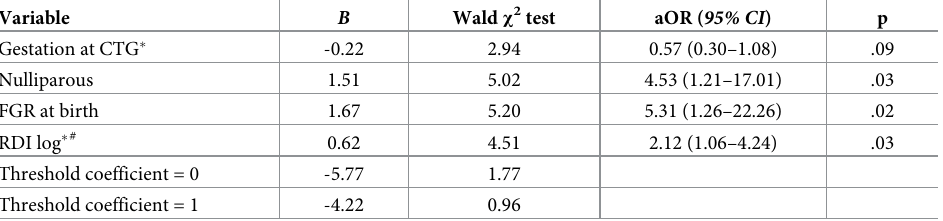
Table 3. Factors associated with number of fetal heart rate events per hour on cardiotocography on stepwise ordi- nal regression modelling.